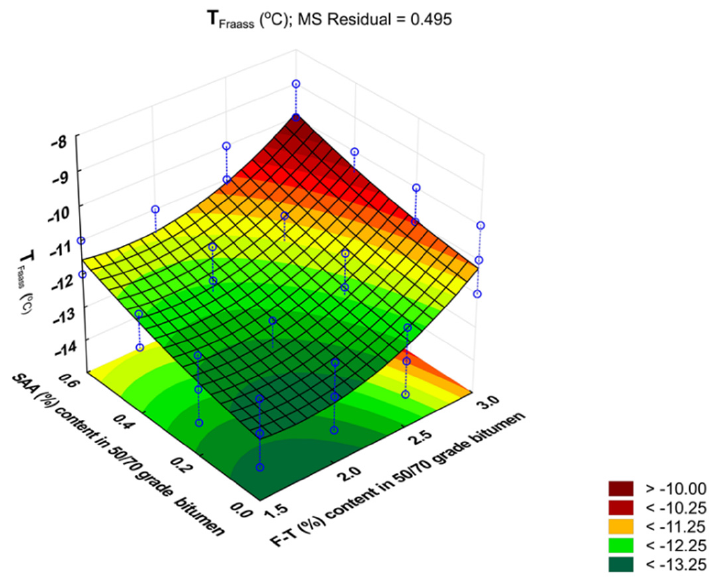
where: Q—quadratic; L—linear.